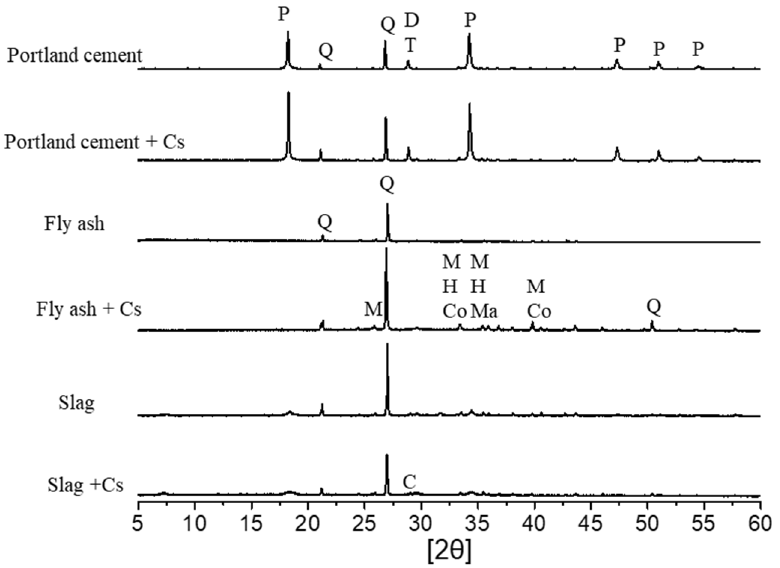
Figure 4. XRD of some geomaterials before and after the incorporation of Cs. P: portlandite, H: hematite, Ma: magnetite, C: C–S–H, M: mullite, Q: quartz, Co: coesite, T: tricalcium silicate, D: dicalcium silicate.